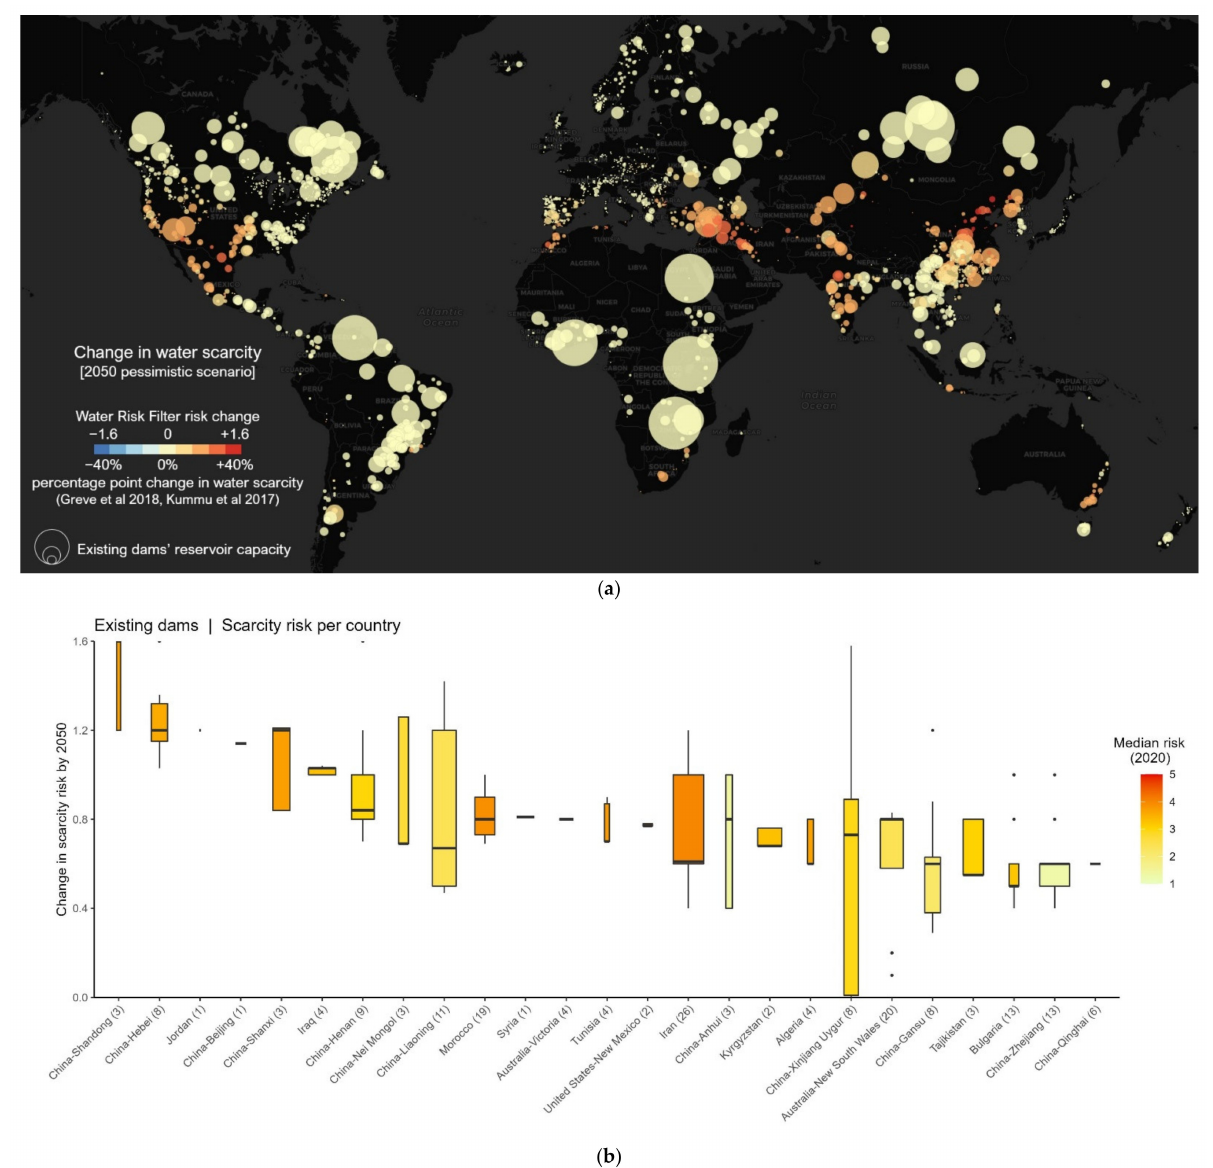
Figure 4. ( a ) Distribution of existing dams with color indicating the projected relative change in basin risk for water scarcity in 2050 under the pessimistic scenario. The size of the circle reflects the hydropower capacity of the dam. See the interactive version of this map at https://rcamargo. shinyapps.io/HydropowerClimateChange.; (accessed 21 January 2022). ( b ) Change in water scarcity risk (vertical axis) for the river basins of existing hydropower dams by 2050 according to country or subnational region under the pessimistic scenario. Bar color indicates current risk and width indicates aggregate hydropower